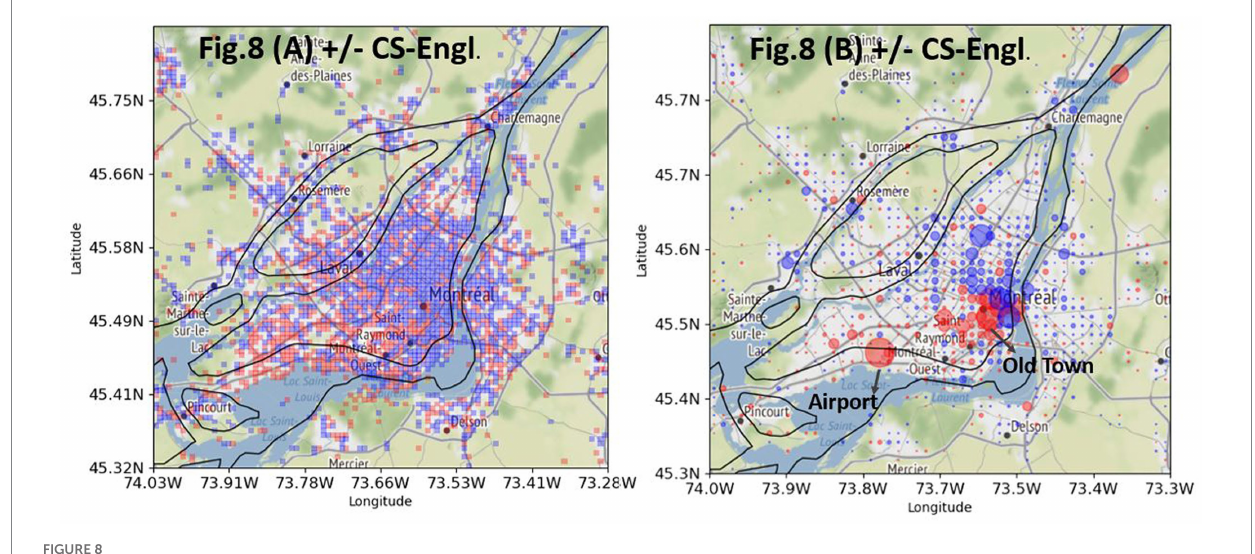
FIGURE 8 Differential distribution of +CS-Engl. (red) and –CS-Engl. (blue) in Greater Montreal. ( A , left): without intensity. ( B , right): with intensity. Base map and data from OpenStreetMap and OpenStreetMap Foundation under the Open Database